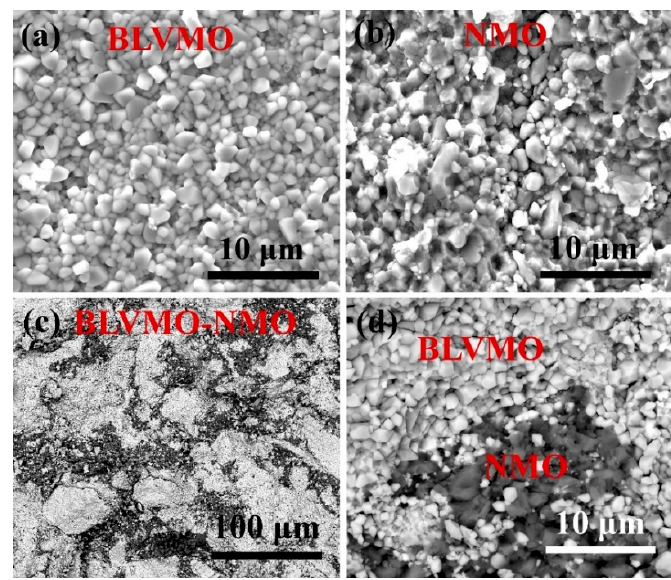
Figure 4. The SEM and BSE images of ( a ) conventionally-sintered BLVMO, ( b ) cold-sintered NMO, and ( c , d ) cold-sintered BLVMO-20 wt.% NMO samples.